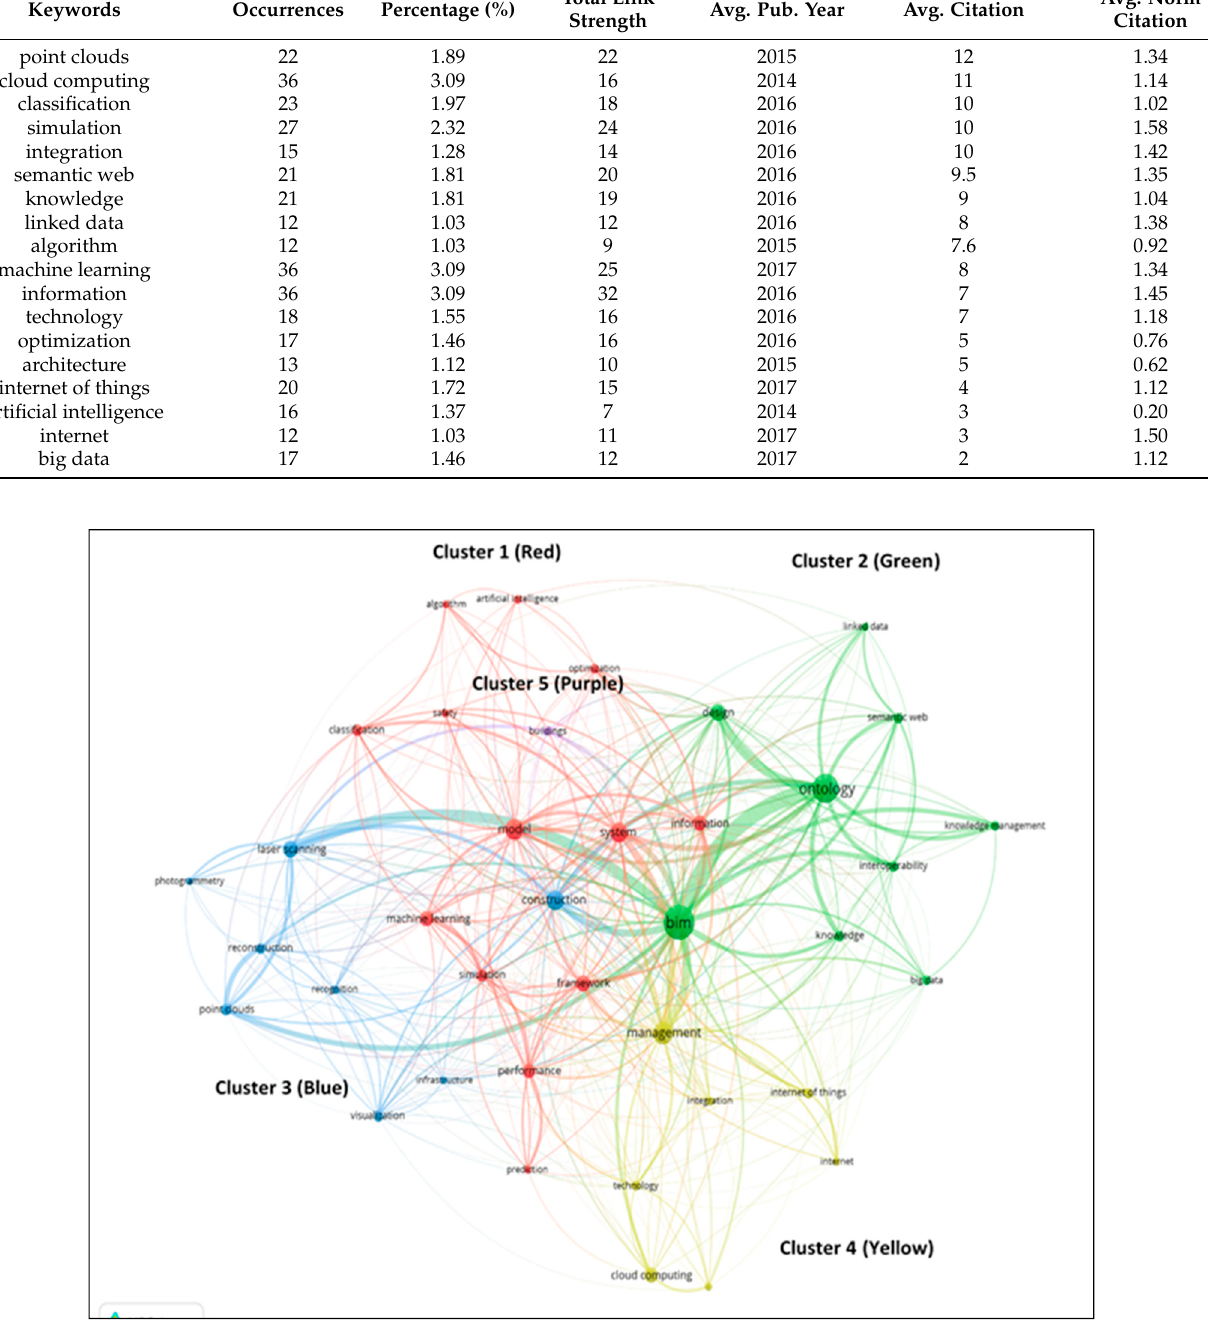
Figure 2. Network visualisation of keywords’ co-occurrence.